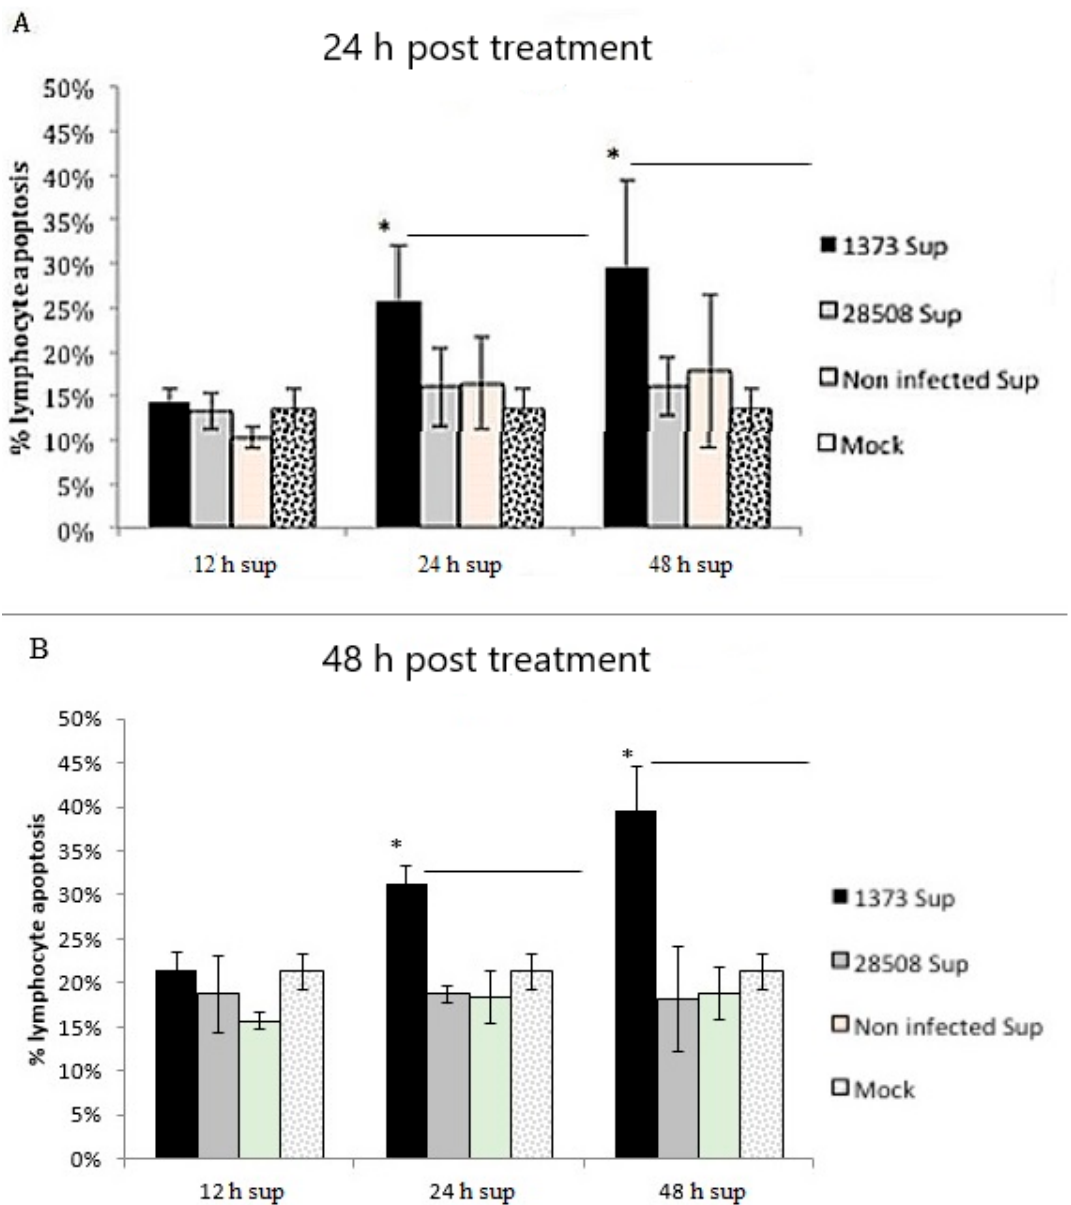
Figure 7. The indirect (infected MDM 12, 24 and 48 h supernatant) and the direct effect of different strains of BVDV on lymphocyte apoptosis. ( A ) The indirect effect 24 h post-treatment ( B ) The indirect effect 48 h post-treatment 1373 Sup: BVDV 1373- infected macrophage supernatant, 28508-5 Sup: BVDV 28508-5-infected macrophage supernatant non-infected Sup: non-infected macrophage supernatant, Mock: culture medium, *: p < 0.05 (>95% confidence).